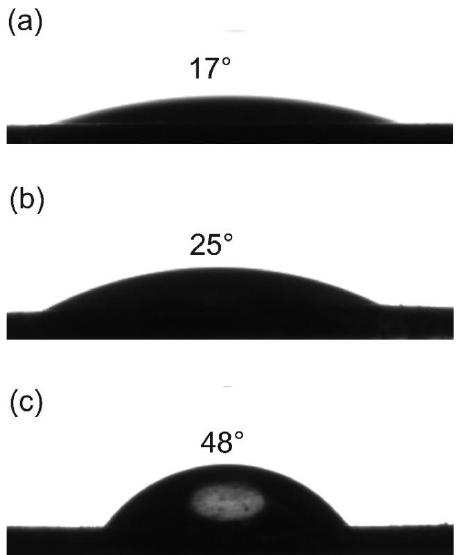
Figure 3. Contact angles of water on Fe 3 O 4 film( a ), Fe 3 O 4 -NH 2 film ( b ), and DC-Fe 3 O 4 film ( c ).